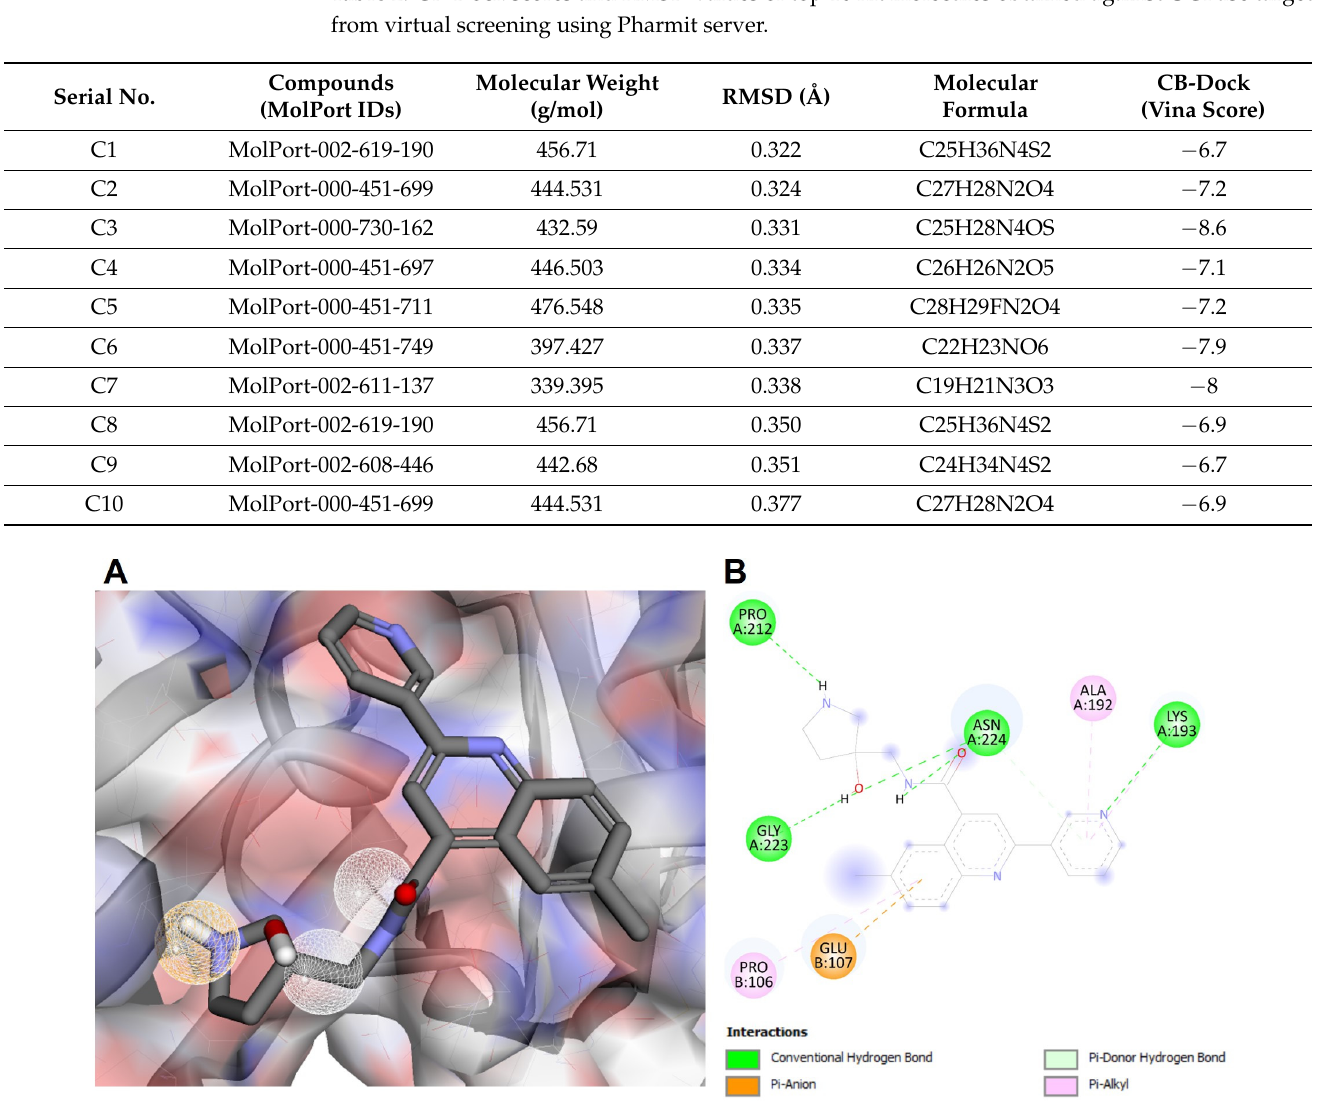
Figure 4. ( A ) The pharmacophore model designed based on the active site of LtPCNA. ( B ) The molecular interaction of top hit compound docked in the active site of LtPCNA. The nature of protein–ligand interactions is represented with different colors. Table 3. CB-Dock scores and RMSD values of top 10 hit molecules obtained against LtPNCA target from virtual screening using Pharmit server .